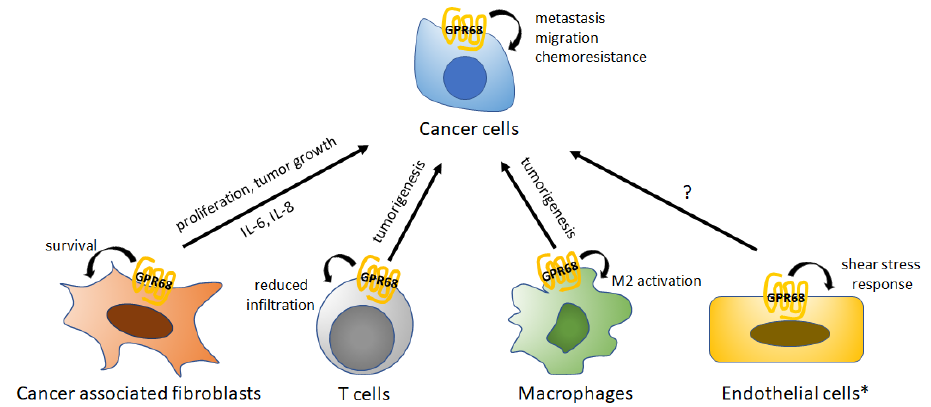
Figure 7. Summary of GPR68 functions in cancer cells and other cells in the tumor microenvironment (TME). GPR68 is expressed on a variety of cells in the TME, each of which has responses to GPR68 activation, as indicated on the figure. * GPR68 has not as-yet been directly shown on tumor endothelial cells, but based on data for vascular endothelial cells are likely to be present in tumors.